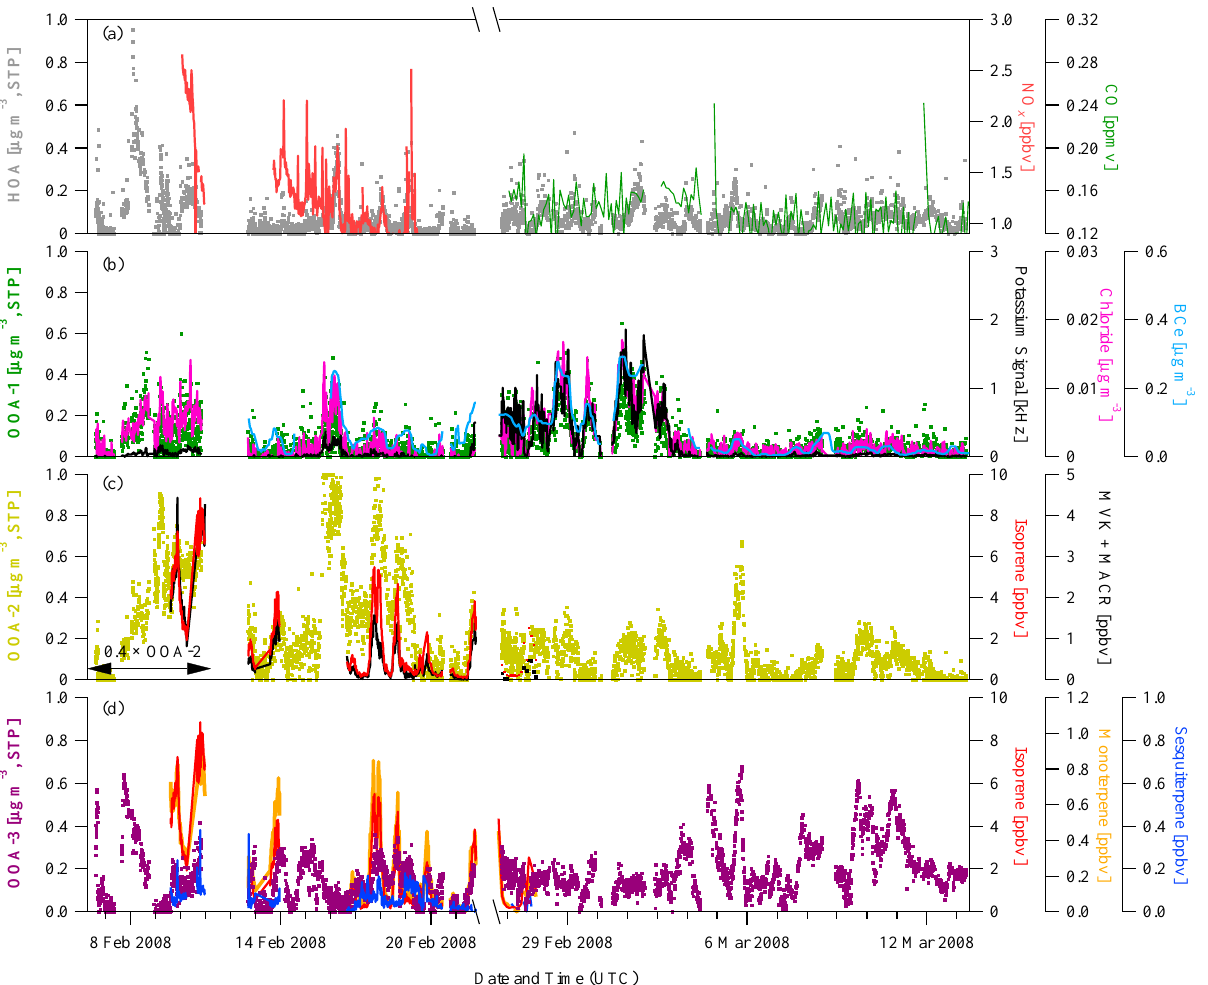
Figure 6. Time series of the loadings for the factors HOA, OOA-1, OOA-2, and OOA-3 (left axes; dots) and time series of the concentrations of tracer species, including NO x , CO, AMS chloride, AMS potassium, aethalometer black carbon, MVK + MACR, isoprene, monoterpenes, and sesquiterpenes (right axes; lines). The BVOCs were measured by proton-transfer-reaction mass spectrometry (PTR-MS; Karl et al.,